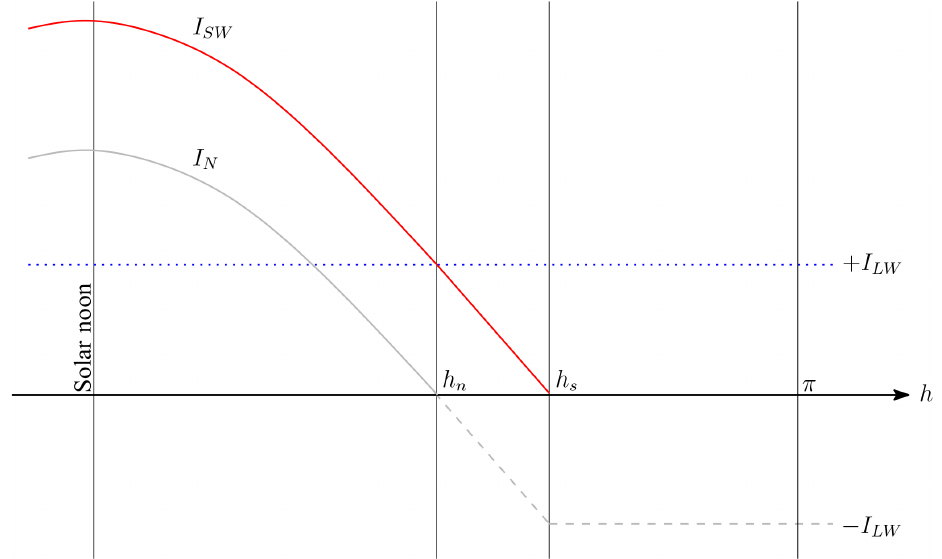
Figure 1. Example of the net radiation flux curve between the hours of solar noon (i.e., h = 0) and solar midnight (i.e., h = π ). The I N curve is equal to the difference between the net incoming shortwave radiation flux, I SW (solid red line), and the net outgoing long-wave radiation flux, I LW (dotted blue line). Positive I N , shown decreasing from solar noon to zero at the cross-over hour angle, h n , is denoted with a solid gray line, while negative I N , shown decreasing from zero to − I LW between h n and the sunset hour angle, h s , and constant between h s and solar midnight, is denoted with a dashed gray line. The solid black horizontal line marks the datum of zero